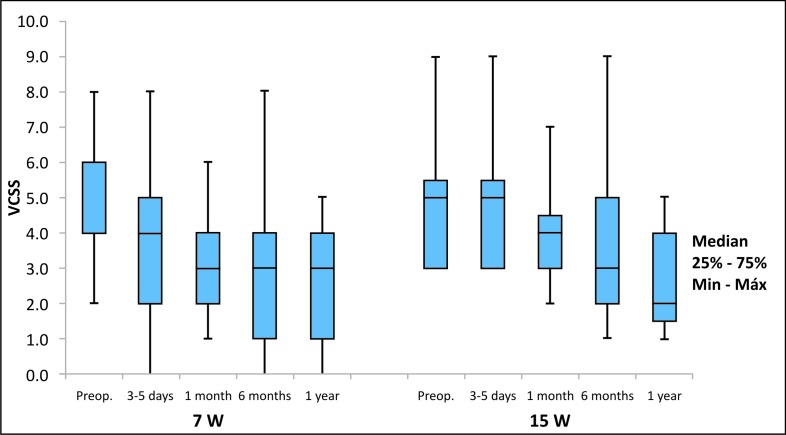
Graph showing results of comparison of the groups considering the venous clinical severity score (VCSS).